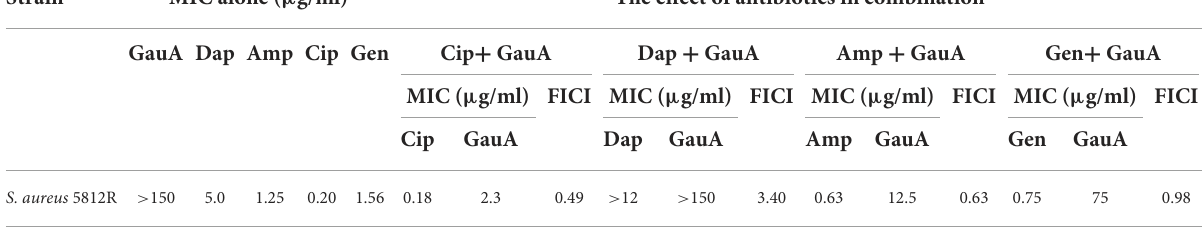
TABLE 5 The in vitro antibacterial activity of gausemycin A in the combination with other antibiotics against S. aureus 5812R. Strain MIC alone ( µ